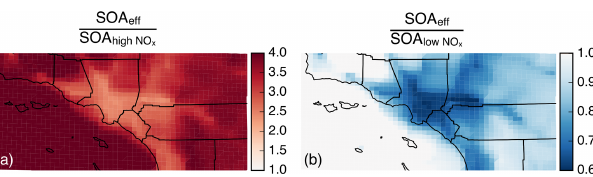
Figure 6. The 14-day-averaged ratio of the SOA eff mass concen- tration to the SOA mass concentration from the (a) high-NO x and (b) low-NO x Base